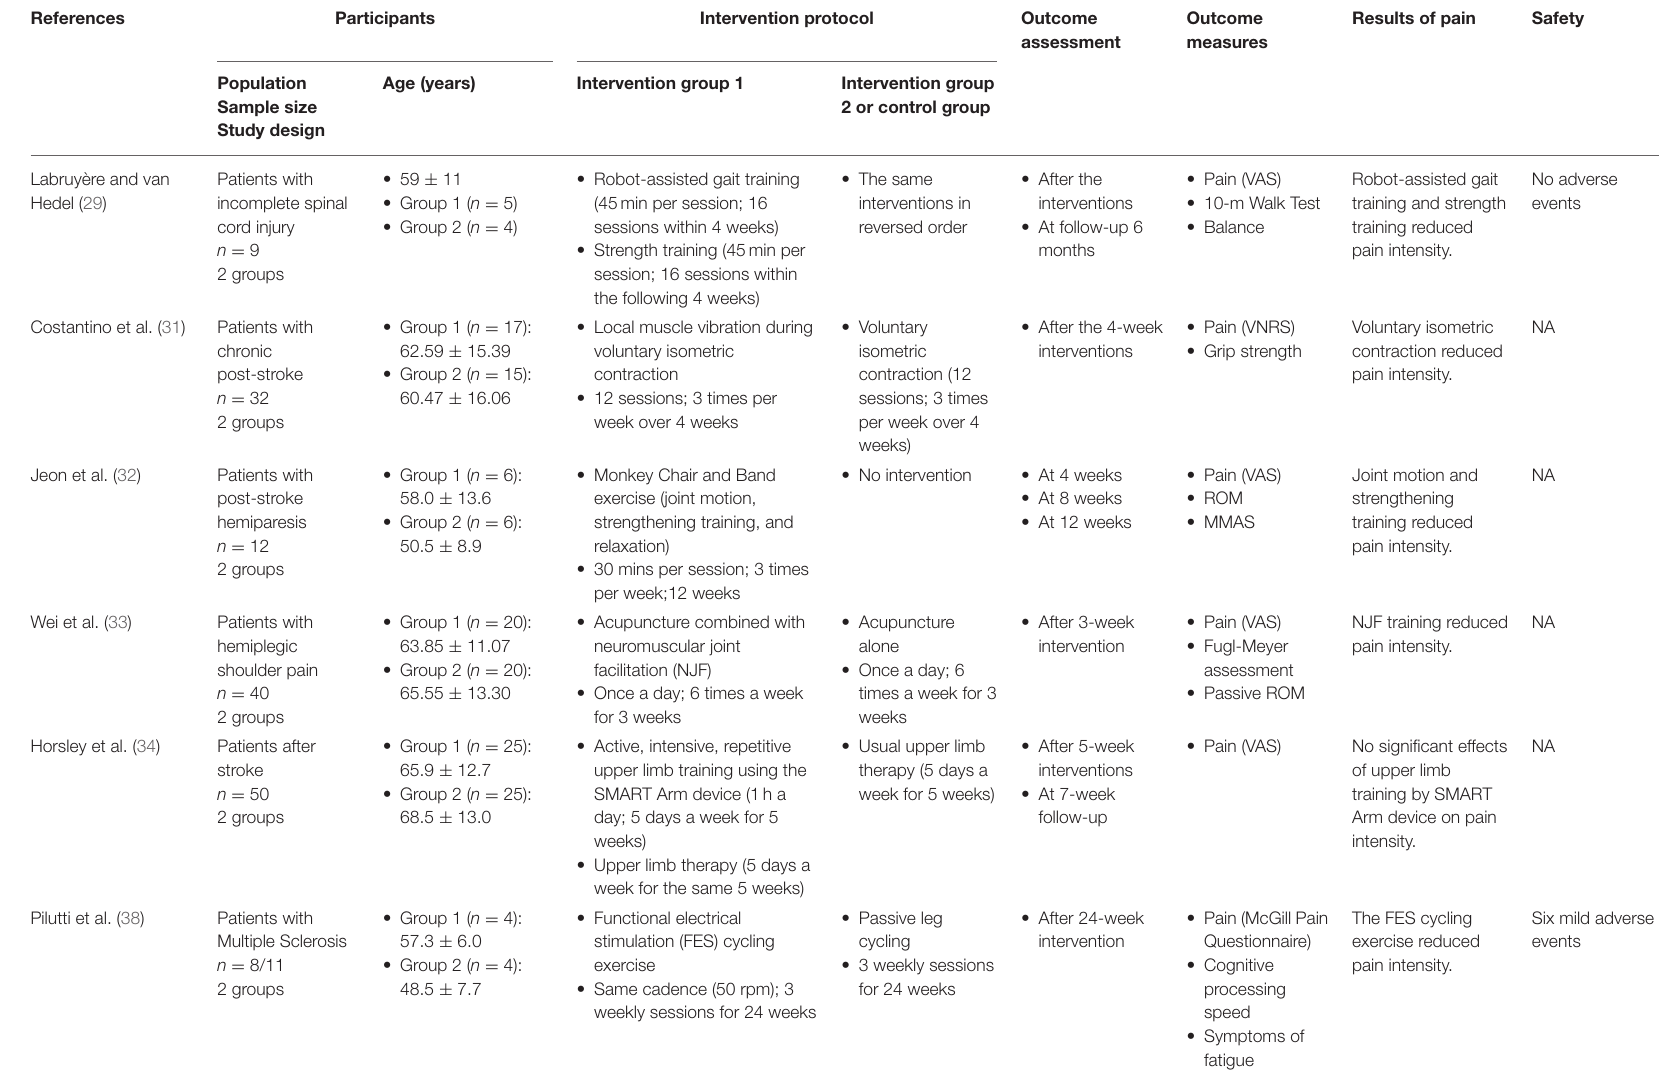
TABLE 3 | Characteristics of included RCT